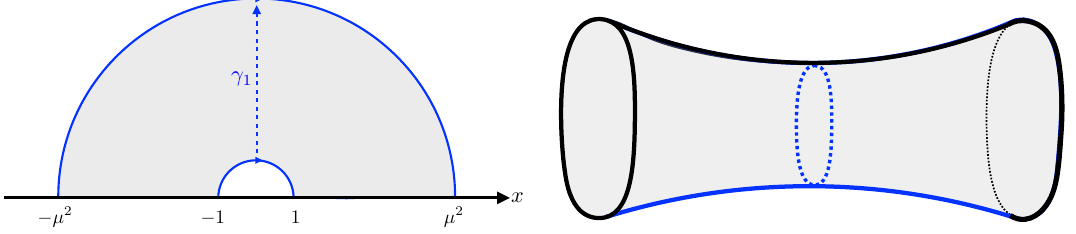
Figure 2 . Left: we display the upper half-plane and the Poincare coordinates. Gray shaded region is a fundamental domain of the identification by γ 1 . In particular, the smaller blue semi-circle is identified by larger one. Right: after the identification, resulting cylindrical geometry becomes a canonical timeslice of the (static) eternal BTZ. The area of horizon (the blue dotted curve in center) can be computed as the length of blue dotted line in the left